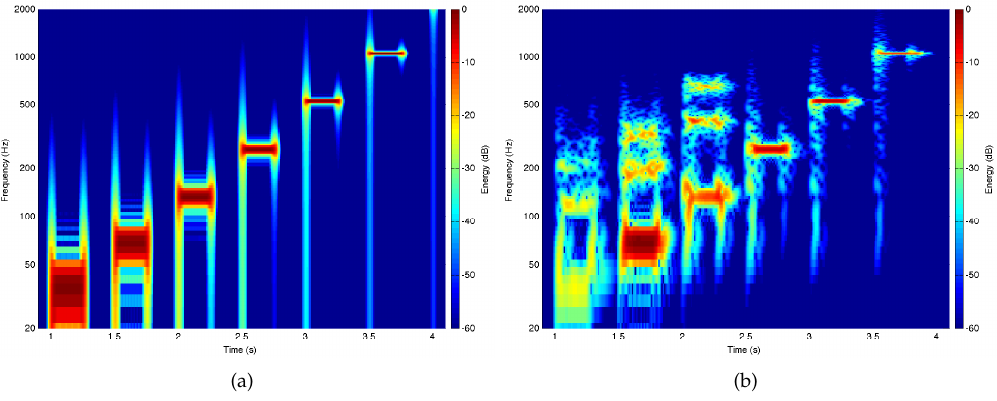
Figure 12. Keyboard split demonstration. ( a ) C0–C5 input signal; ( b ) Driving keyboard split.